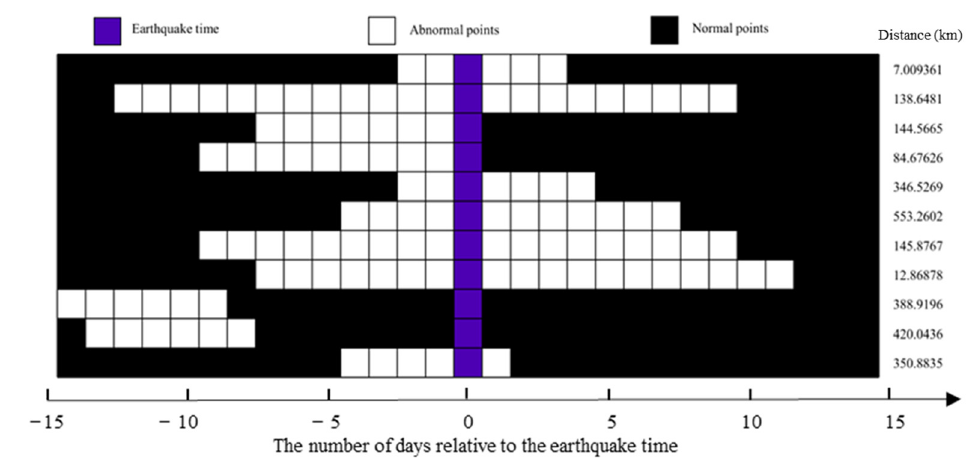
Figure 12. The spatiotemporal diagram of pre-seismic anomalies.